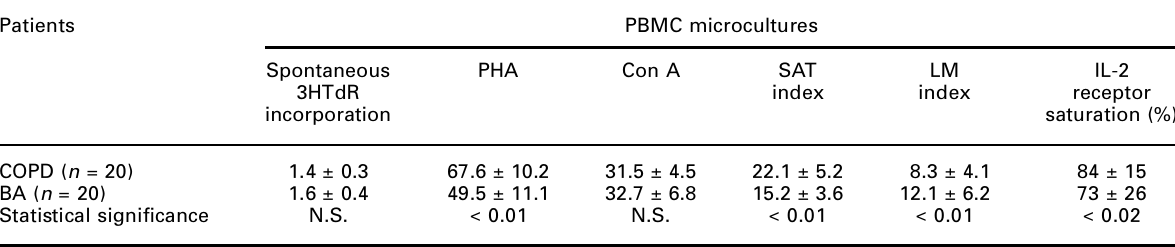
Table 1. Response to mitogens [PHA and Con A (dpm ´ 10 3 /culture)] and immunoregulatory indices (SAT index, LM index, and IL-2 receptor saturation) in PBMC microcultures from patients with COPD and BA